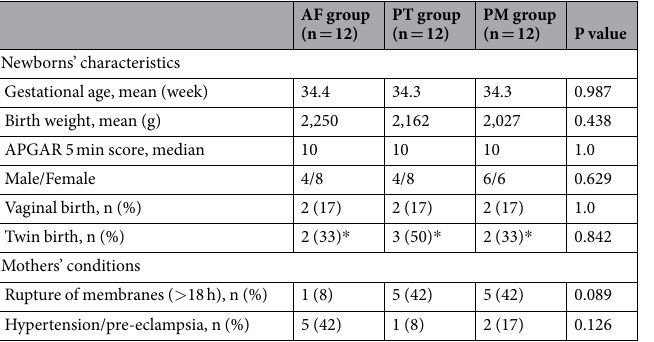
Table 1. Demographic and clinical characteristics of study subjects. * Two subjects were counted for each twin in calculating the percentages. Fisher’s Exact test was used for categorical variables and Kruskal-Wallis Test was used for continuous variables. P < 0.05 was considered as